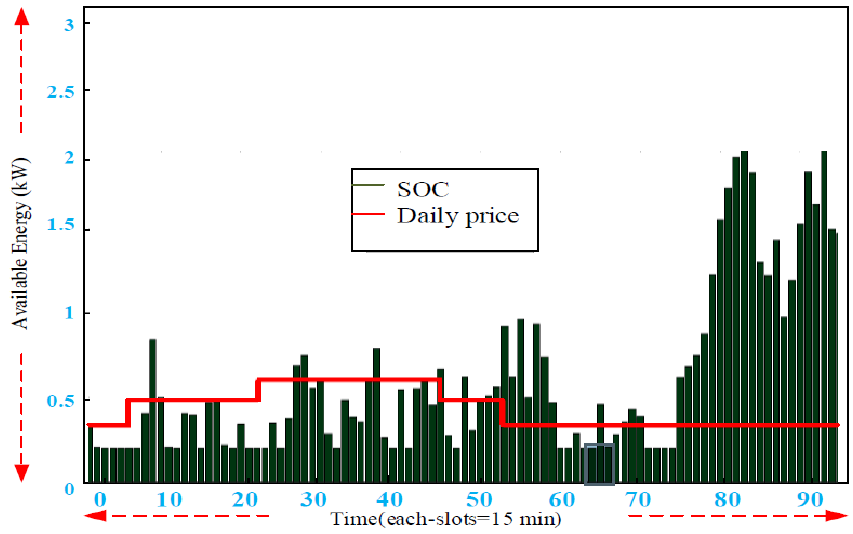
Figure 18. Storage charge level. Power generation and consumption in the HAEMS smart home network are not the same. Figure 19 shows this difference.